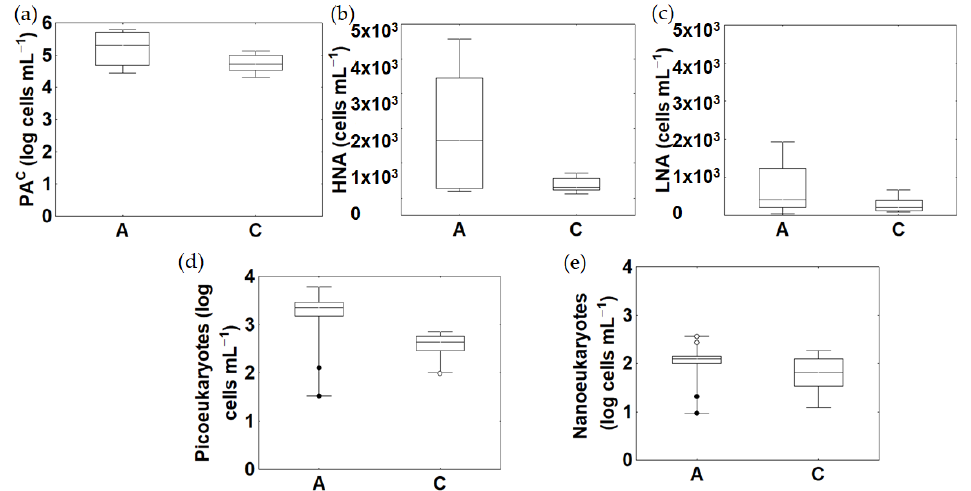
Figure 6. Box plots of microbial parameters studied by Flow Cytometric analysis: ( a ) Total prokaryotes, ( b , c ) High- and Low-Nucleic Acid cells (HNA and LNA), ( d , e ) Pico- and Nano-eukaryotes. The boxes are characterized by a median line and boundaries indicating 25th and 75th percentiles; whiskers area characterized by a vertical line indicating 5th and 95th percentiles. White dots = outliers, black dots = extreme